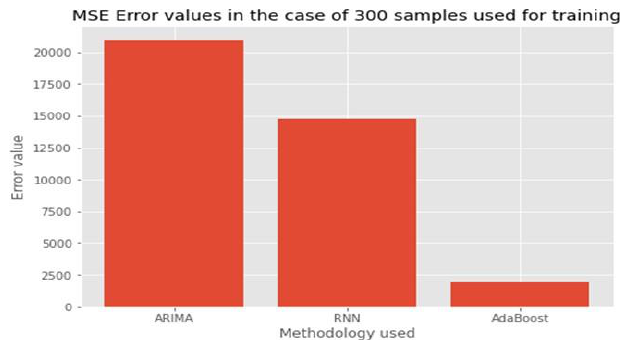
Figure 14. Comparing the MSE between RNN, ARIMA, and AdaBoost for 300 samples.